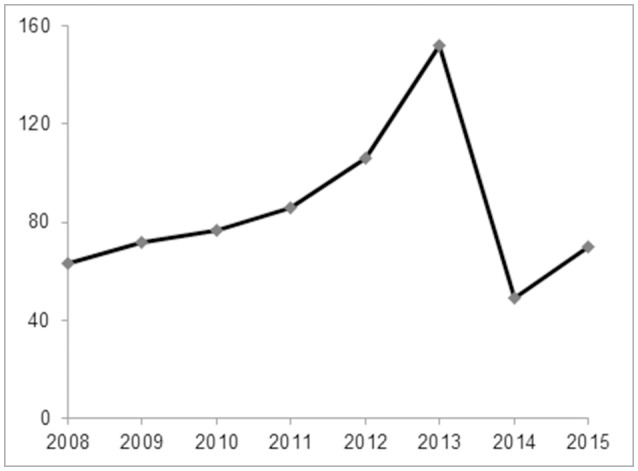
The annual case number of RMPP between January 2008 and December 2015. The number of patients enrolled in 2013 (152 cases) was the most followed by 2012 (106 cases), while only 49 patients were enrolled in 2014, which coincided with a RMPP outbreak around 2012-2013.